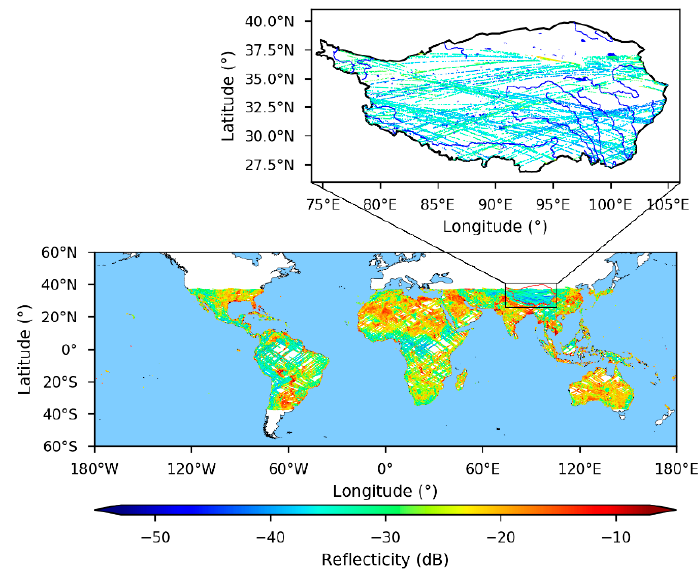
Figure 3. Cyclone Global Navigation Satellite System (CYGNSS) specular point reflectivity in the Qinghai-Tibet Plateau on January 1, 2018. Blue areas are water bodies.